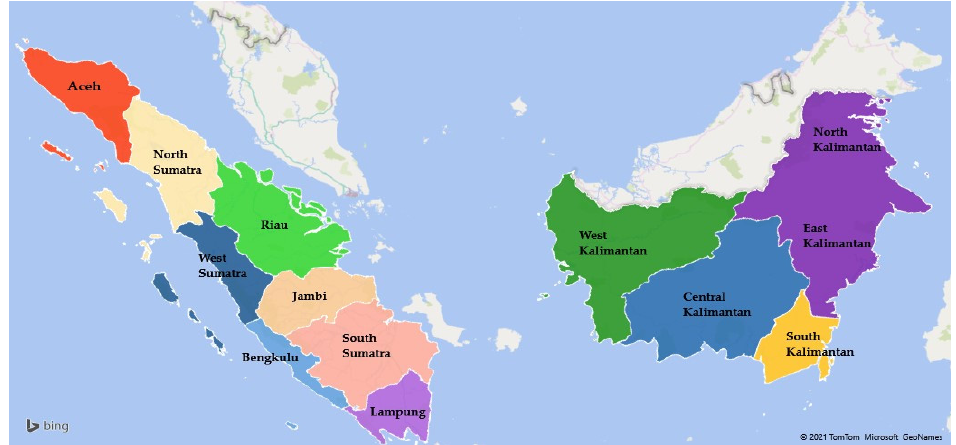
Figure 2. Map of the areas in the systematic review study, presenting various provinces on Sumatra and Kalimantan islands.